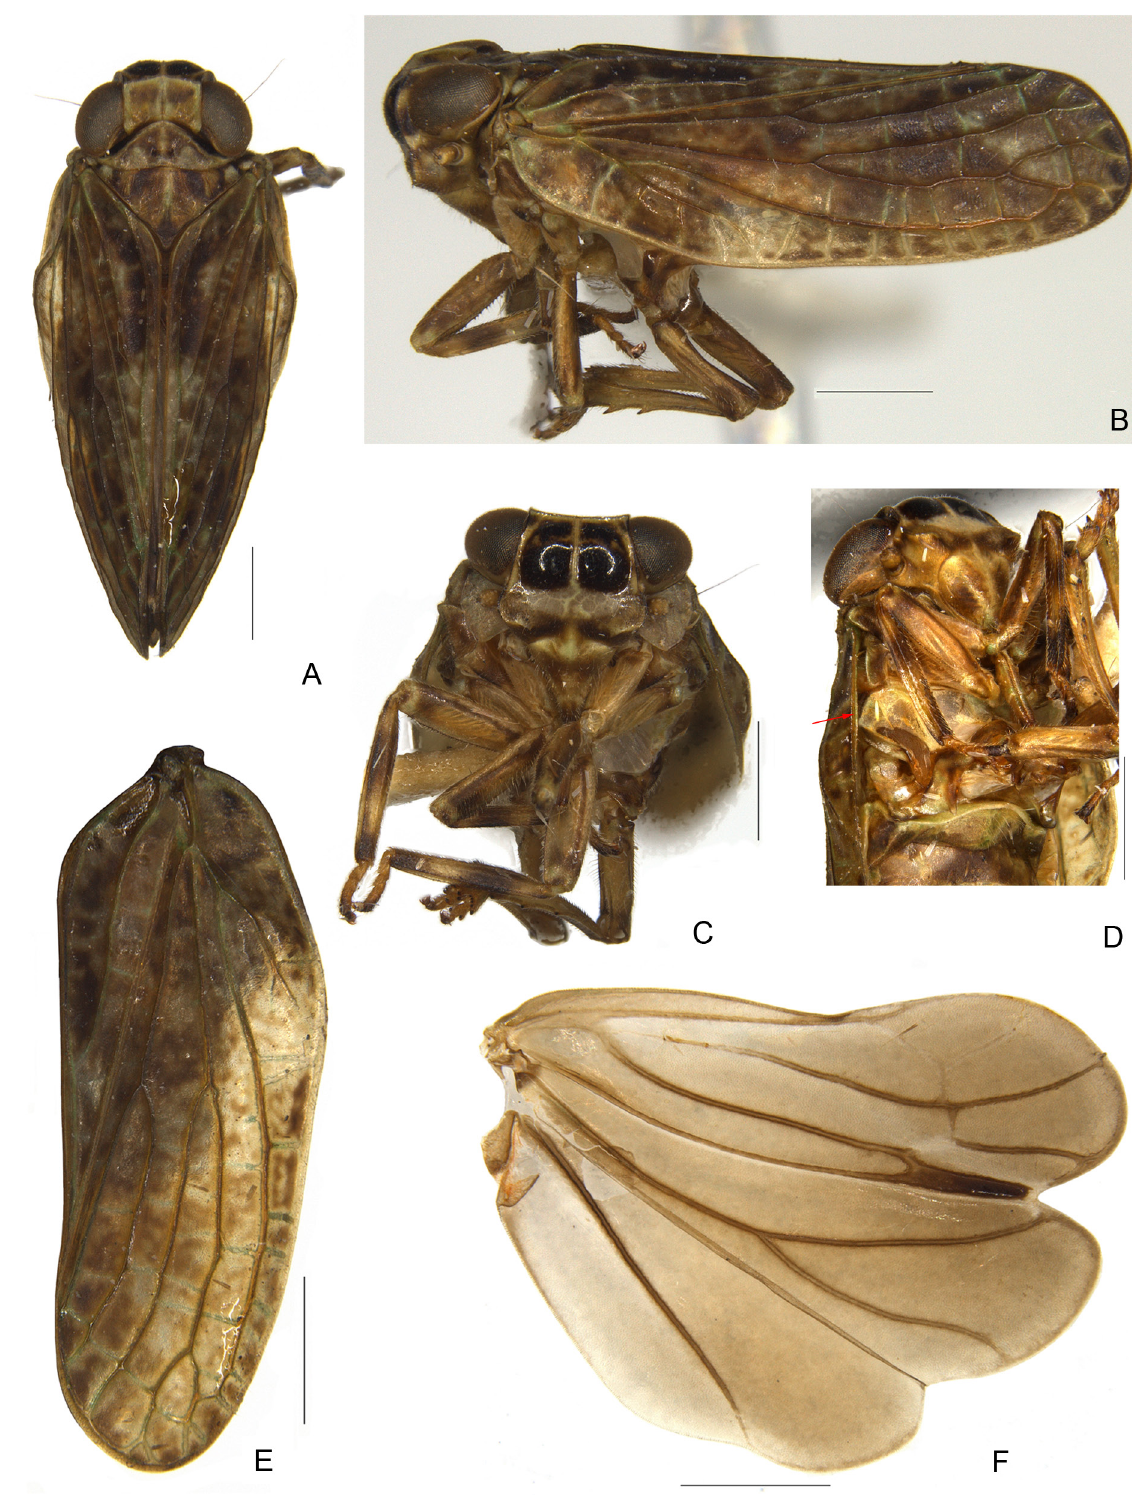
Fig. 4. Orbita parallelodroma Meng & Wang, gen. et sp. nov., holotype. A . Habitus, dorsal view. B . Habitus, lateral view. C . Frons and clypeus. D . Head and thorax, latero-ventral view. E . Tegmen. F . Hind wing. Scale bars = 1